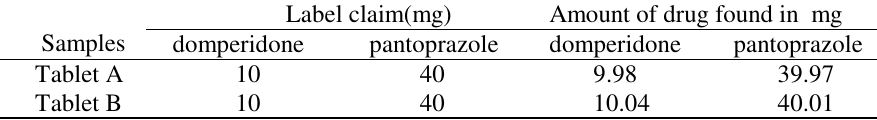
Table 2 Determination of domperidone and pantoprazole in combined tablet dosage form Label